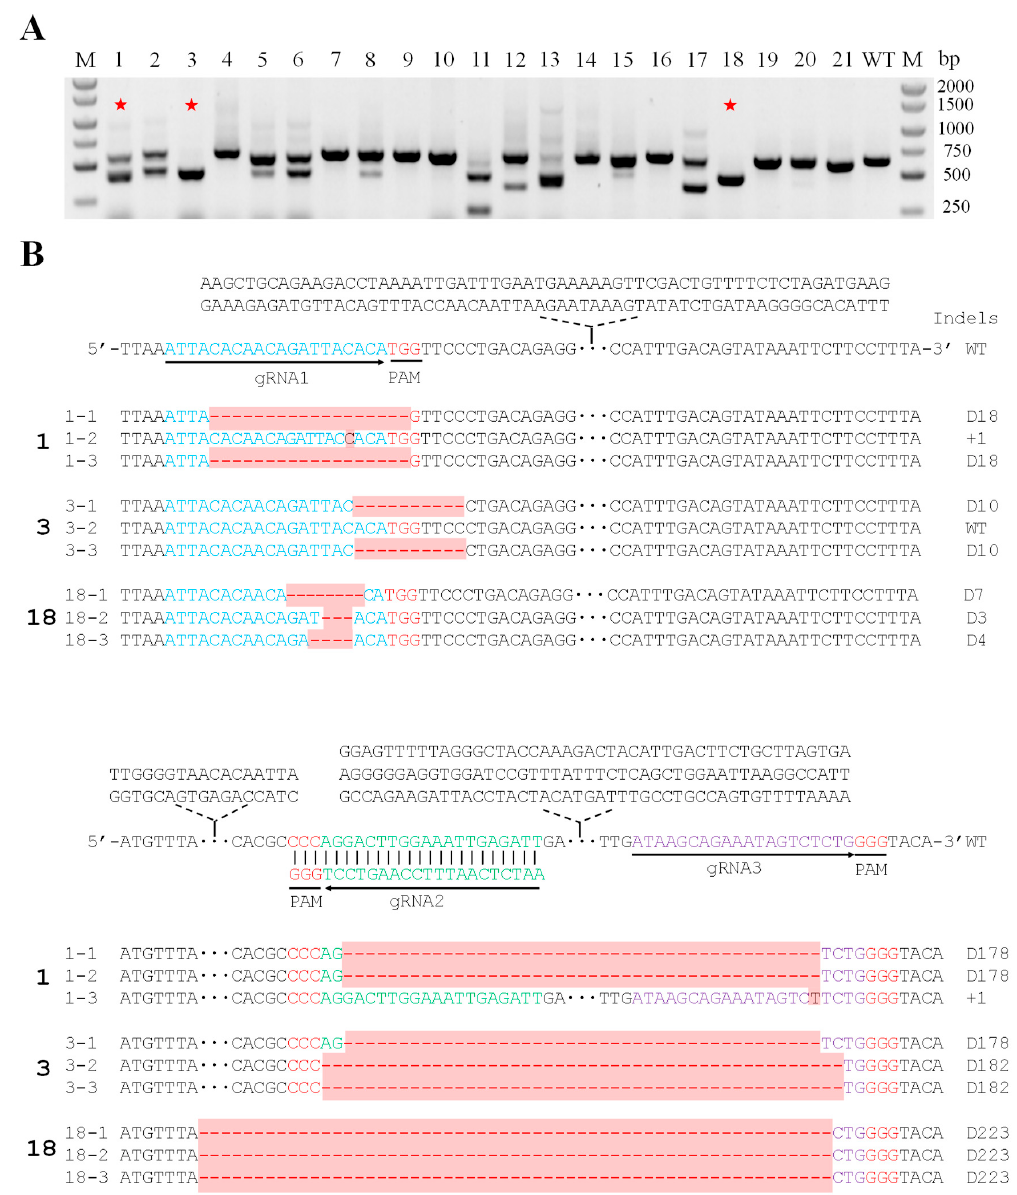
Figure 3. CRISPR / Cas9-induced mutations on the VuSYMRK gene. ( A ) PCR detection of CRISPR / Cas9-induced mutations of the VuSYMRK . Lanes 1–21, sequence amplified from genomic DNA isolated from hairy root transgenic cowpea plants by primers (SYMRK-gDNA-F / R). M, DNA marker; WT, wild-type plant; red star, sequenced transgenic lines. ( B ) Mutations between gRNA target sites on VuSYMRK gene. blue font, gRNA1; green font, gRNA2; purple font, gRNA3; red font, PAM sequence; D3 / 4 / 7 / 10 / 18 / 178 / 182 / 223, nucleotide deletions; + 1, 1 bp insertion; DNA insertions or deletions are highlighted in red.